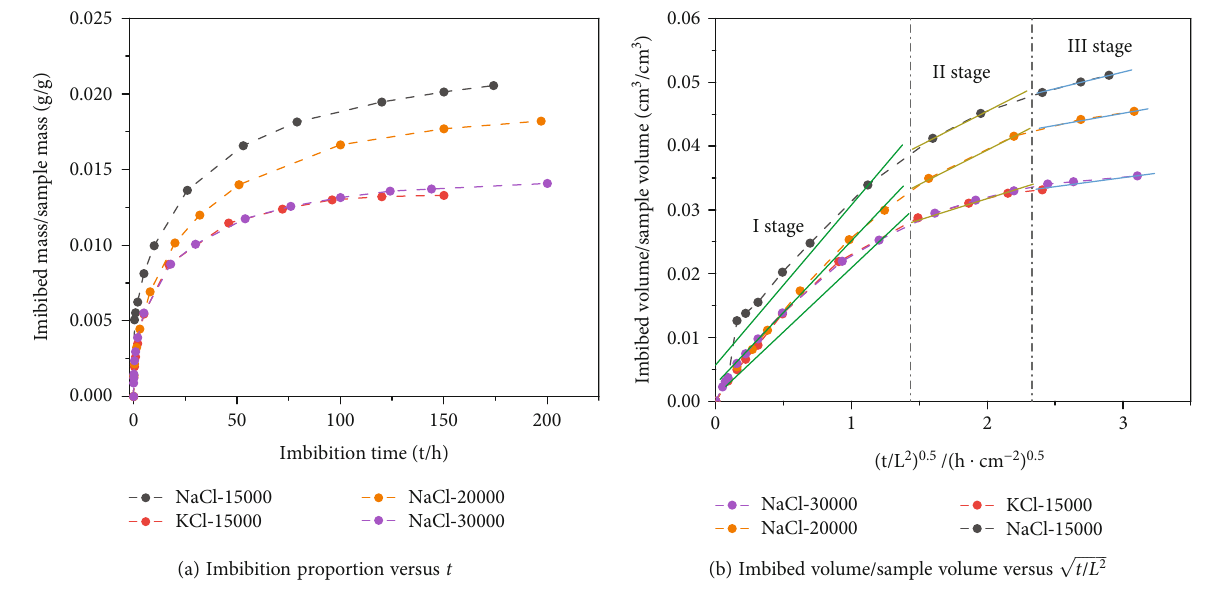
Figure 12: Imbibition characteristic curve of the deep shale samples in di ff erent salt